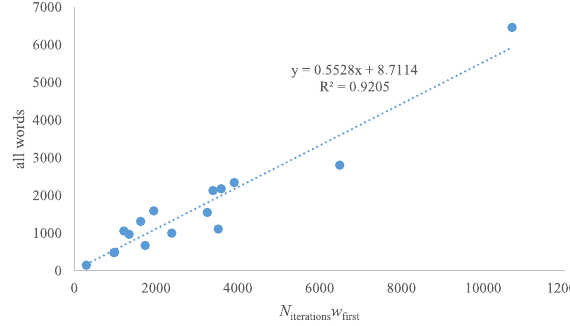
FIG. 1. The plot of total words versus words in the first feedback times the number of iterations. The coefficient in the fit was used to estimate the total words in the feedback for those reports, for which we could not retrieve all the